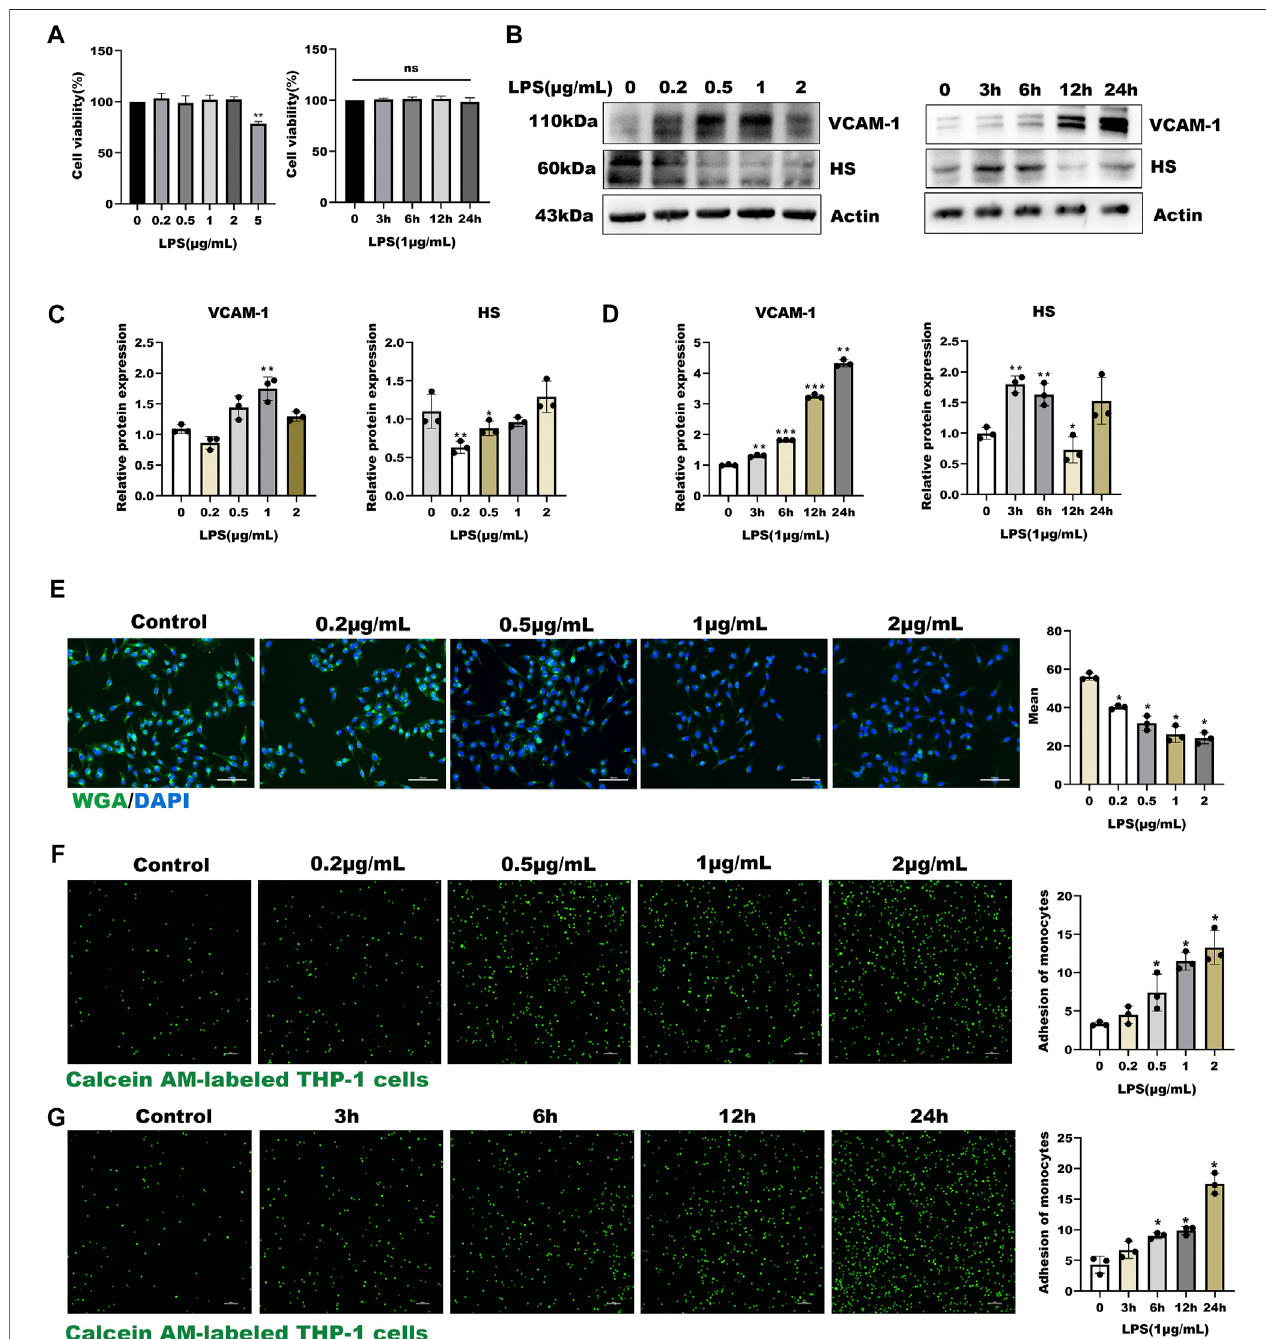
FIGURE 1 | LPS induced glycocalyx loss and endothelial dysfunction in HUVEC (A) Effects of HUVEC treated with LPS at different concentrations and time on cell viability (B – D) Western blot analysis of VCAM-1 and HS in HUVEC treated with LPS at different concentrations and time (E) HUVEC total glycocalyx level were also detected by fl uorescence microscopy analysis using WGA Lectin FITC (Green), DAPI (Blue), and Mean fl uorescence quantitative statistic ( n (cid:2) 3) (F – G) HUVEC were treated with LPS at different concentration and time. Monocyte adhesion to endothelial cells was quanti fi ed via monocyte adhesion assay. Calcein AM-labeled THP-1 cells were incubated with HUVEC. Bar: 100 μ m * p < 0.05. ** p < 0.005; *** p < 0.001.